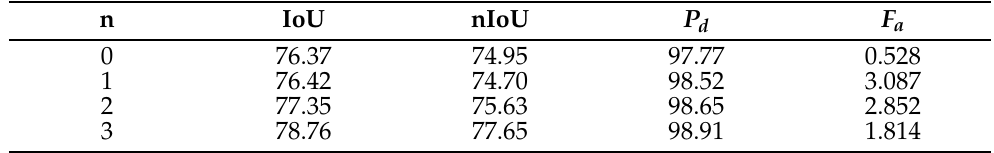
Table 4. Ablation study of the number of GCLs (n) for the IoU (%), nIoU (%), P d (%), and F a (10 − 5 ). n